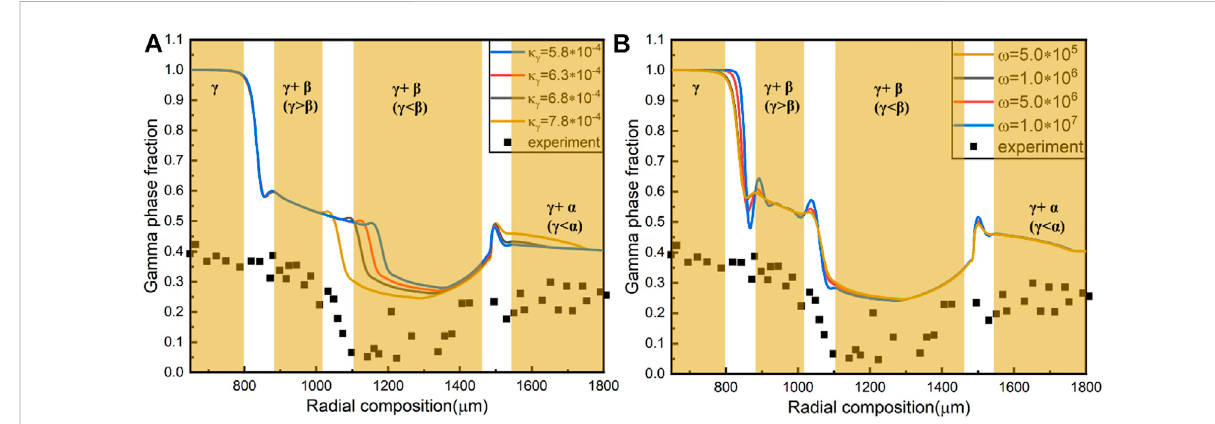
Figure 5. One boundary between two-phase areas is shown as the white areas in Figure 5. The values of d γ at boundaries between two-phase areas are also not equal to 1, and in most cases, they are not fi xed values. Therefore, we fl exibly de fi ned the area where the phase fraction γ has obvious saltation as the phase